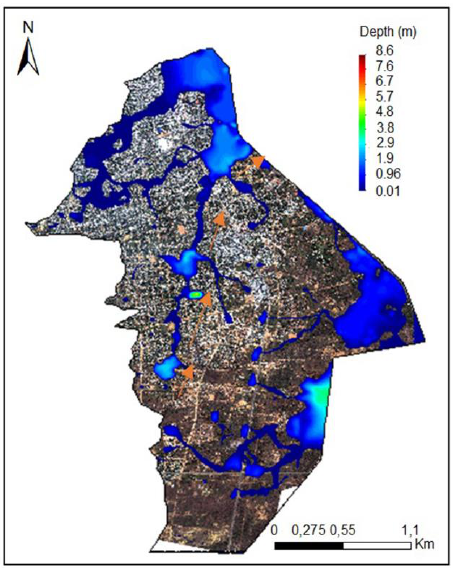
Figure 7 Figure 7. Flow path within the study area as obtained with IBER, calibration